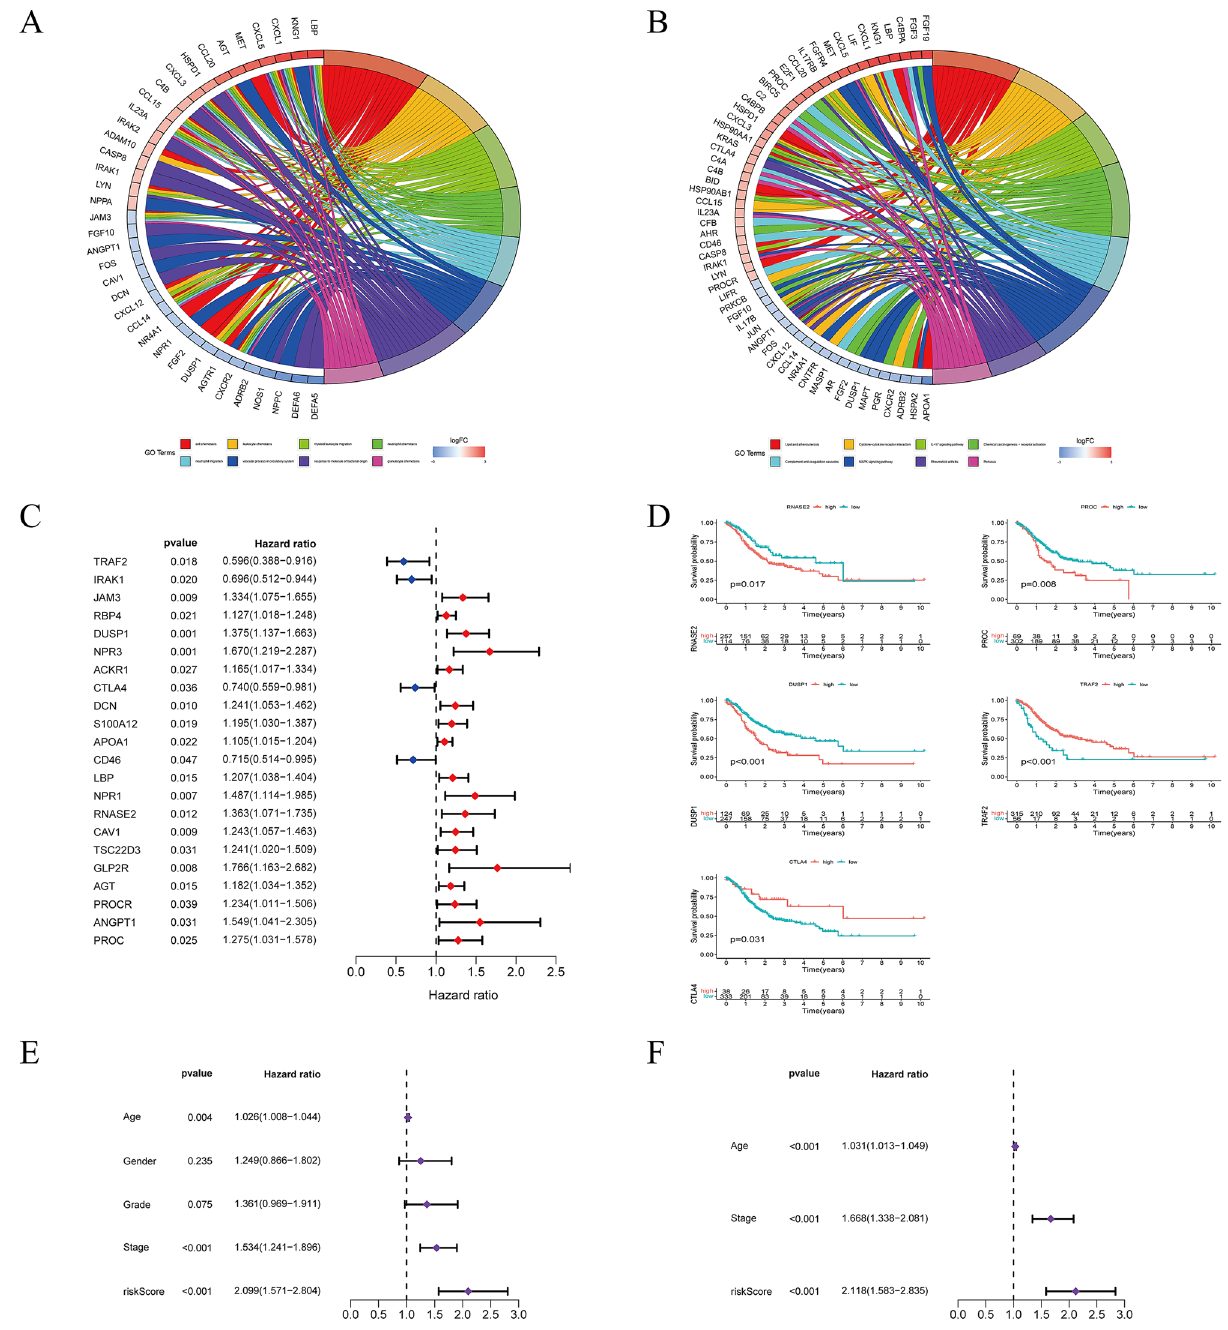
Figure 2. Screening of immune-related prognostic genes and development of IRGPI. ( A ) Gene Ontology (GO) analysis for the immune-related hub genes. ( B ) The Kyoto Encyclopedia of Genes and Genomes (KEGG) pathways for immune-related hub genes. ( C ) Univariate Cox analysis of 22 immune-related genes. ( D ) Kaplan– Meier survival analysis curves for five model genes. ( E , F ) Univariate and multivariate Cox regression analysis on IRGPI and other clinicopathologic factors. [Figures created by R, version